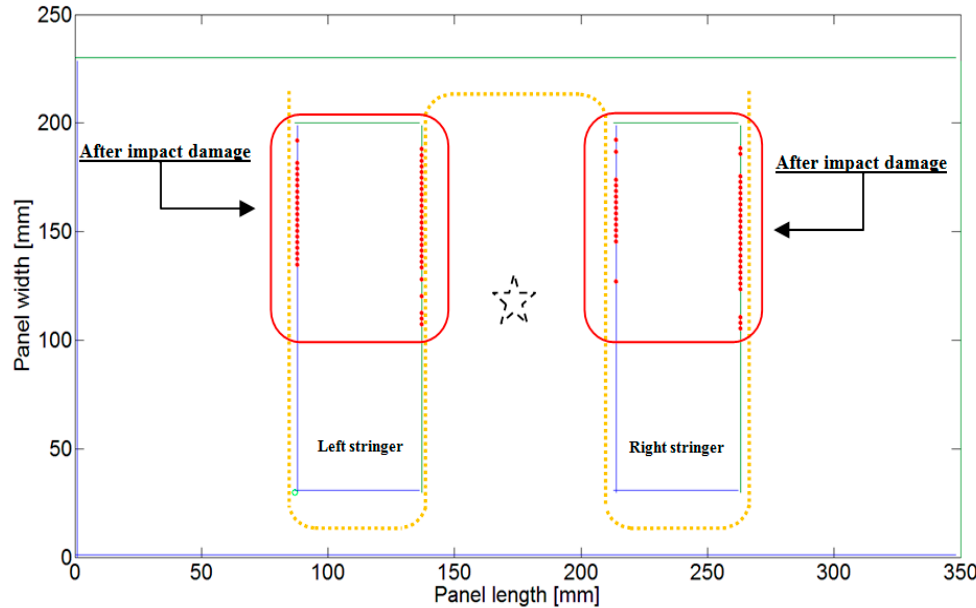
Figure 9. Damage index and threshold level (red line) estimated from the Damage Index (DI).